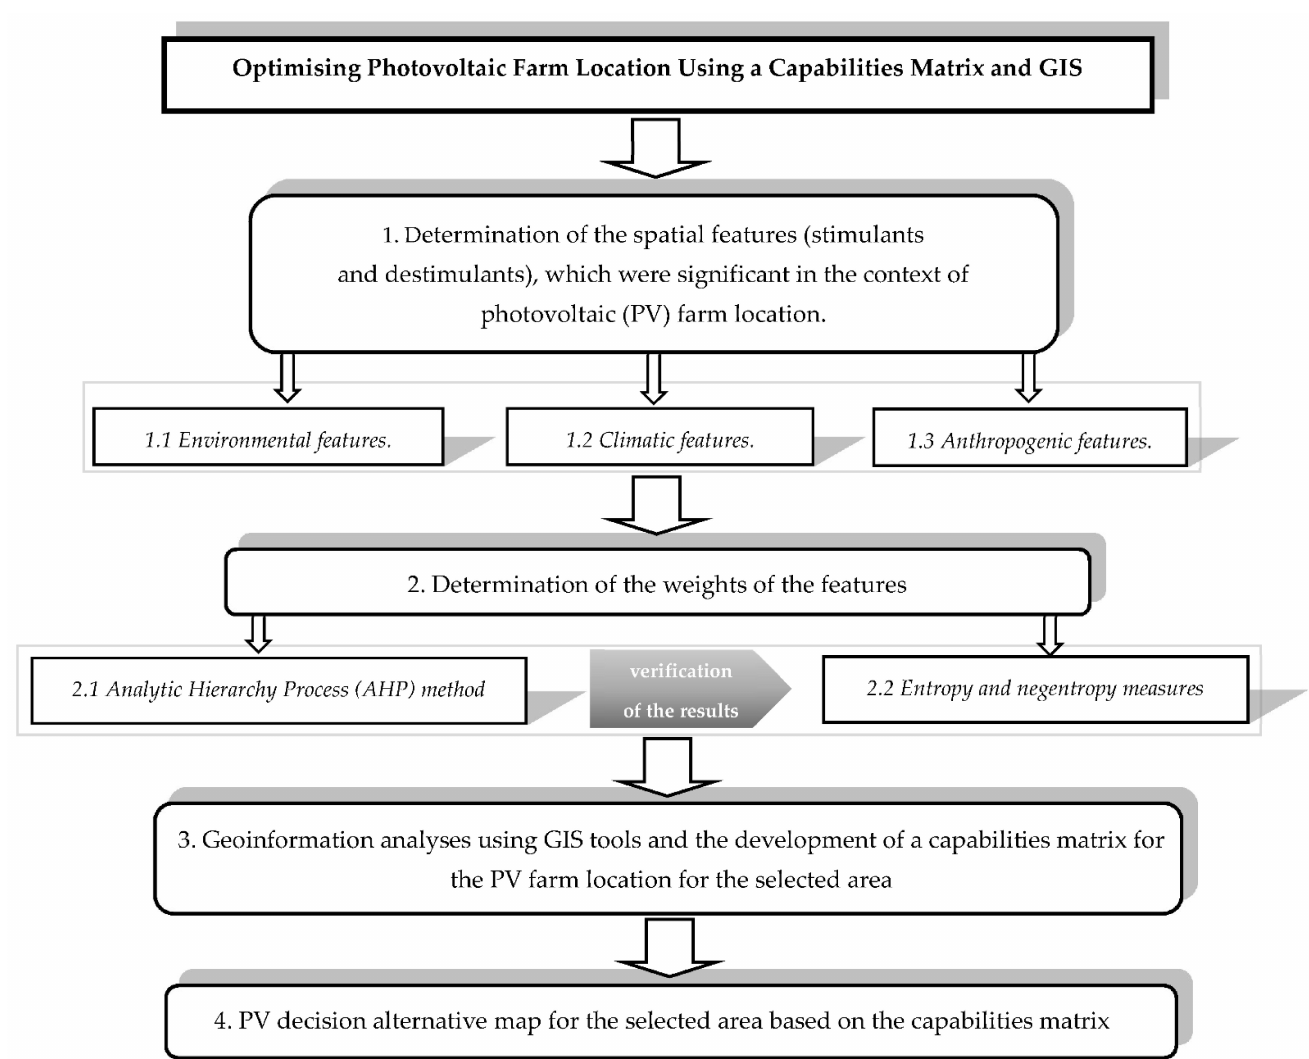
Figure 6. The procedure for developing the capabilities matrix and decision alternative map for the PV farm